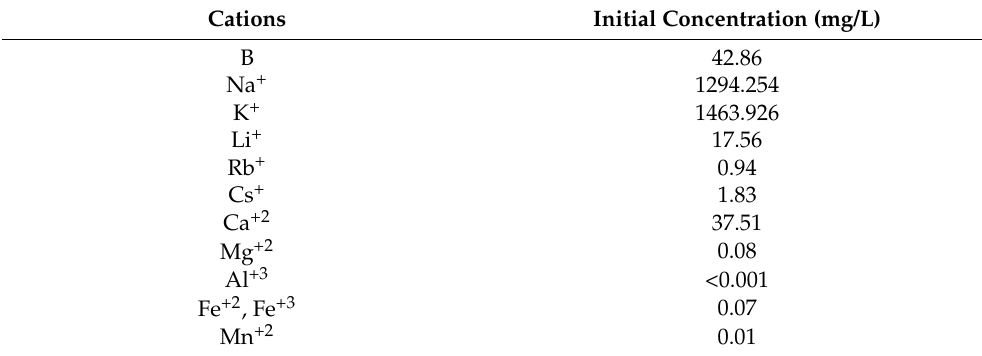
Figure 3. Suggested transport mechanism of boron. Table 6. Concentration of detected cations in a geothermal water sample and RF values of the transport.